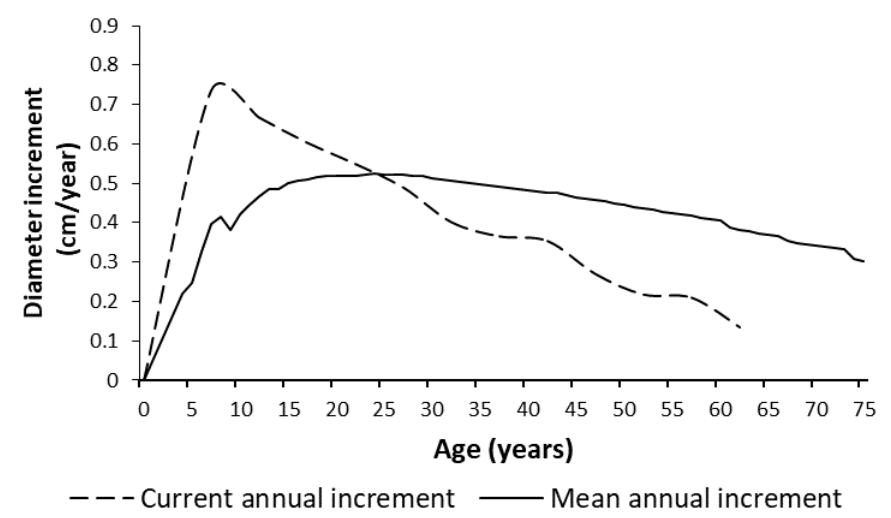
Figure 6. Development of each variable (mean value and standard error every ten years) from stud- ied crop trees of each growth type: dominant type, variable type, and suppressed type. Top left : h/d ratio (80 indicates the limit value of stability), top right : height development; bottom left : diameter development and bottom right : volume development. The stem volume at 75 years of trees of dom- inant type has a lower number of trees than in previous ages (in the age of 75 years there was data from fewer trees to be considered in the mean value).